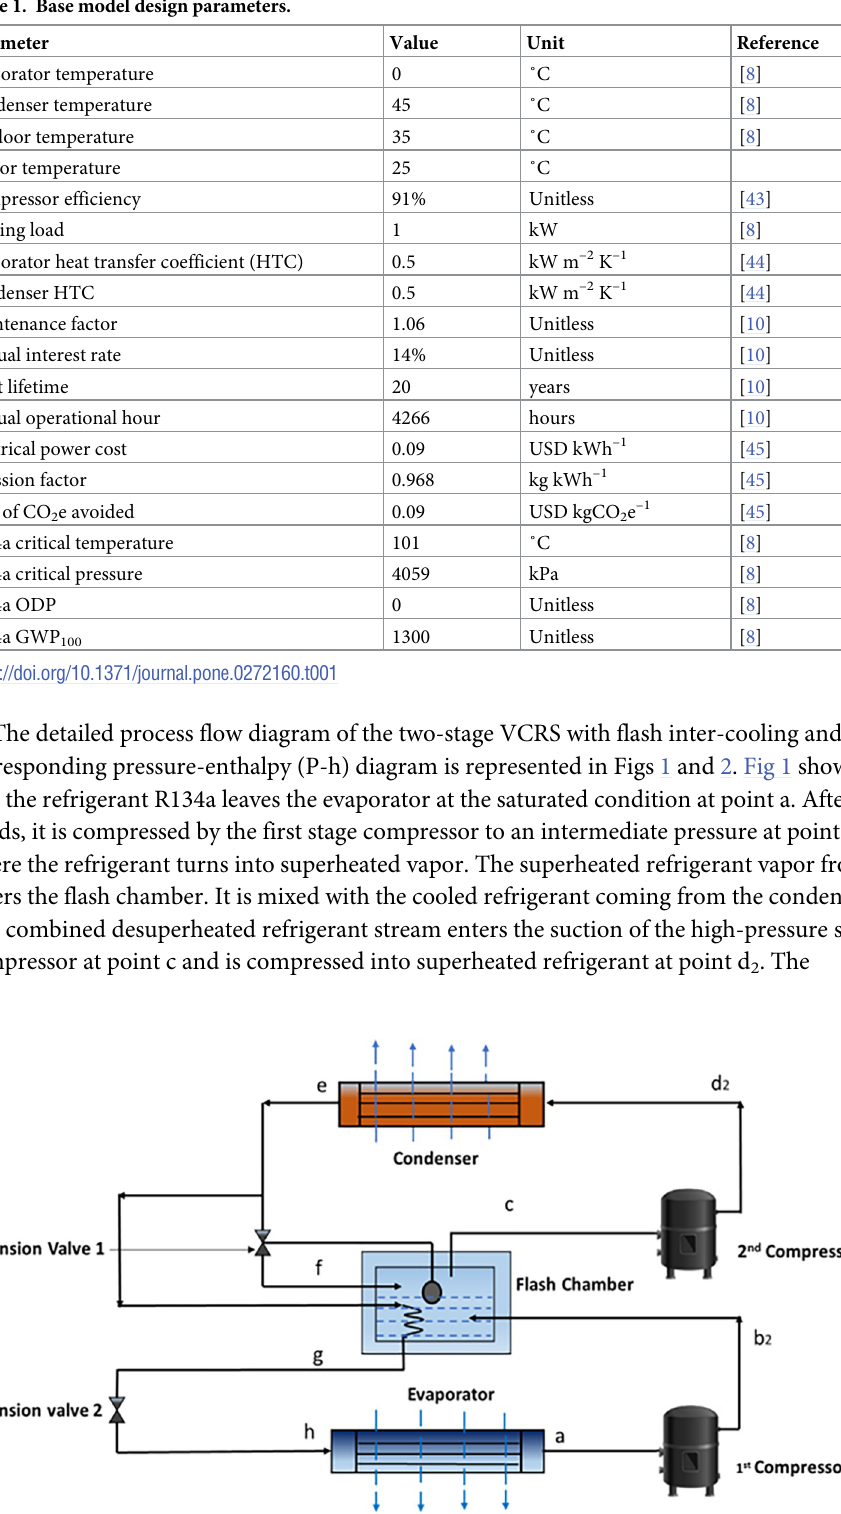
Fig 1. Schematic of the two-stage VCRS with flash